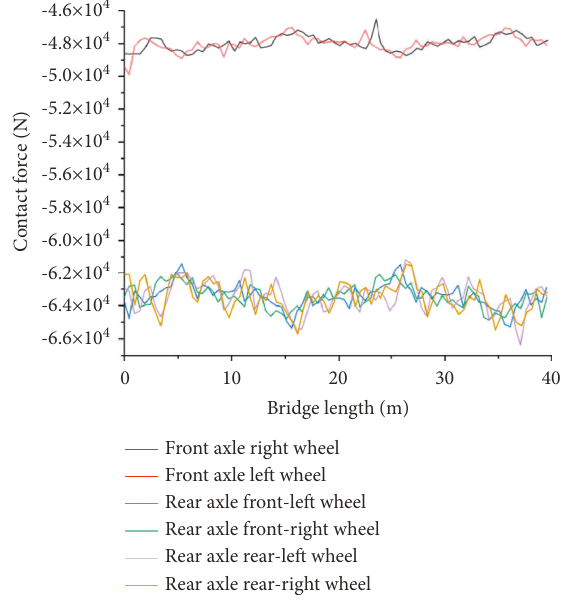
Figure 15: Contact forces at six vehicle axles.